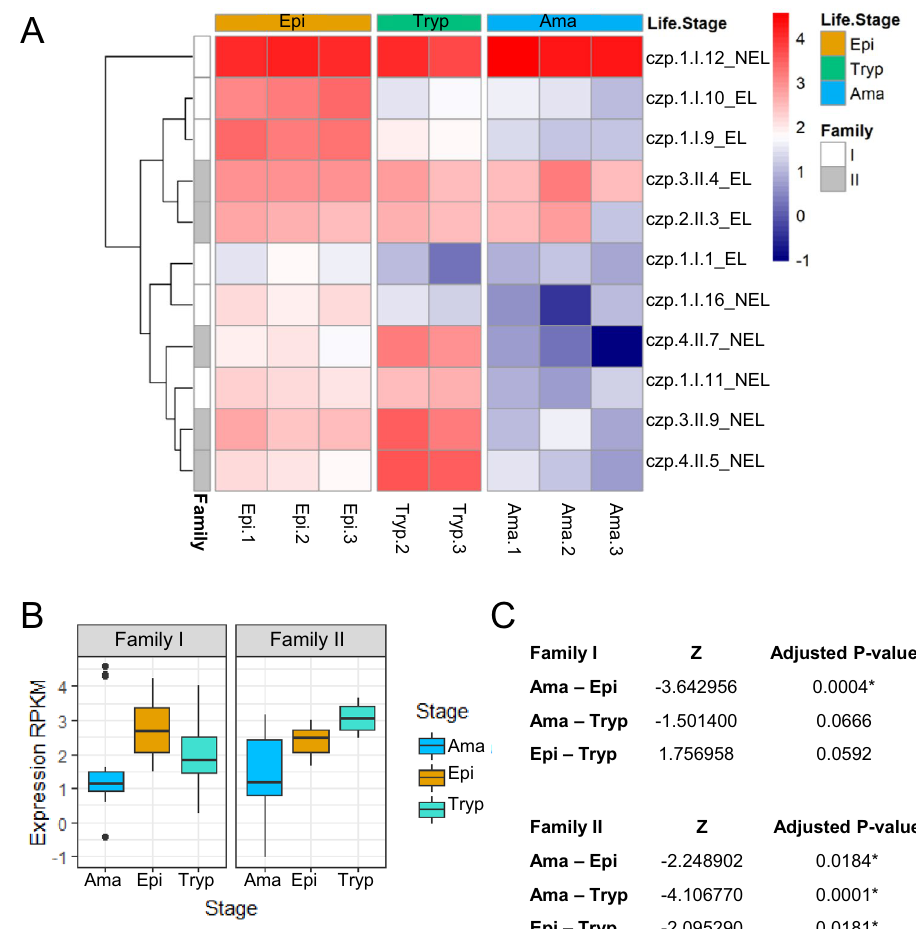
Figure 5. Expression profile of cruzipains in CL Brener. ( A ) Heatmap representing the expression values (log2RPKM) of 11 sequences coding cruzipains belonging to the two clusters in different stages of the life cycle of T. cruzi (Epi, epimastigotes; Tryp, trypomastigotes; Ama, amastigotes) in CL Brener Esmeraldo-like (EL) and non-Esmeraldo-like (NEL) haplotypes. Rows represent each sequence, and columns represent three library replicates derived from epimastigotes and intracellular amastigotes and two library replicates derived from trypomastigotes. The expression values are represented in a color grade scale, where red represents higher expression levels, and navy blue represents lower expression levels. The sequences were clustered according to their expression values. The T. cruzi life stages and cruzipain families are represented in different colors in the x and y-axis, respectively. ( B ) Boxplot representing the log2RPKM expression in Family I and Family II cruzipains, in the amastigote (Ama), epimastigote (Epi), and trypomastigote (Tryp) stages. ( C ) Z test statistics and adjusted P values (Benjamini-Hochberg) for each pair of comparisons of the Family I and Family II cruzipain gene expressions. * P values <